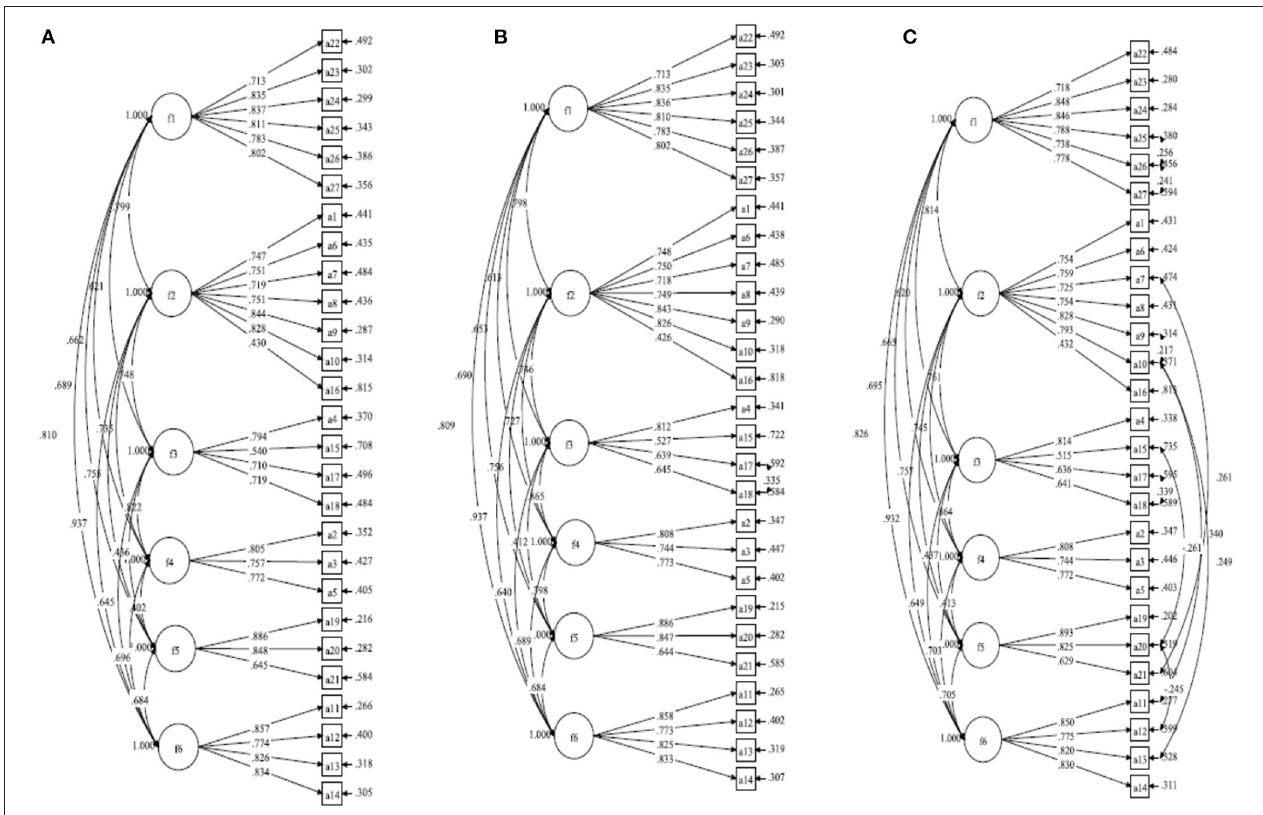
FIGURE 2 | Standardized factor loading for (A) Model-1, (B) Model-2, and (C) Model-8.